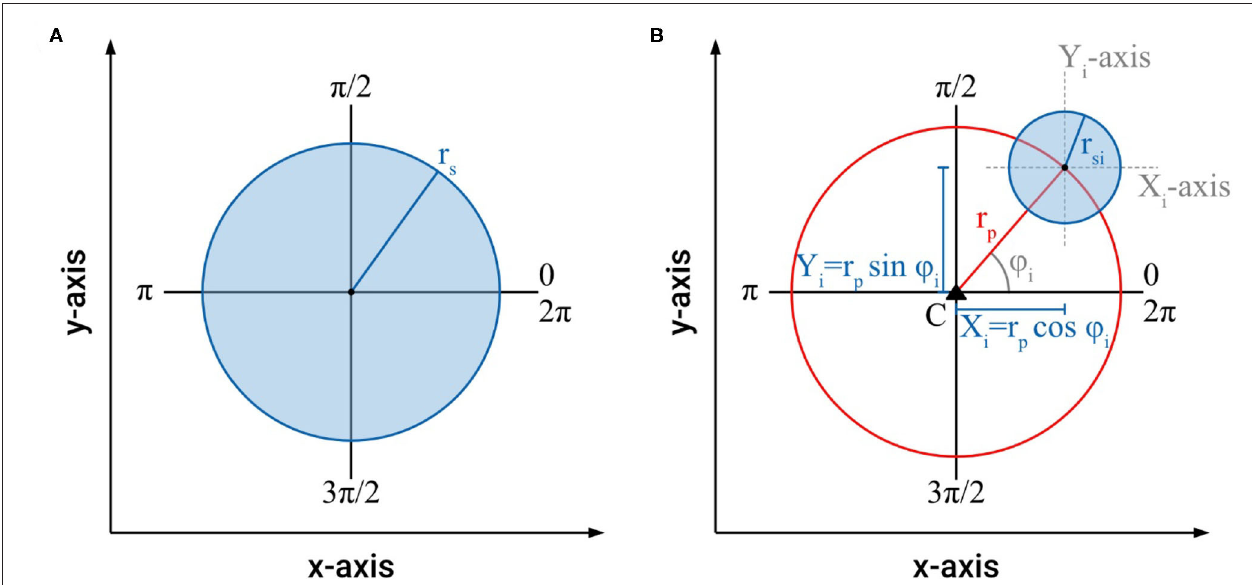
FIGURE 5 | (A) Schematic of the cross-section of a single stem with radius r s with the parameters used to calculate cross-sectional area and axial second moment of area, (B) schematic of the cross-section of an individual stem with radius r si arranged at a distance r p from the centroid C of a braided structure with the parameters used to calculate cross-sectional area and axial second moment of area.